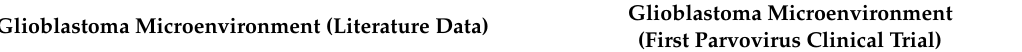
Table 1. Main characteristics of glioblastoma microenvironment as described in the literature or observed in H-1 parvovirus-treated glioblastoma